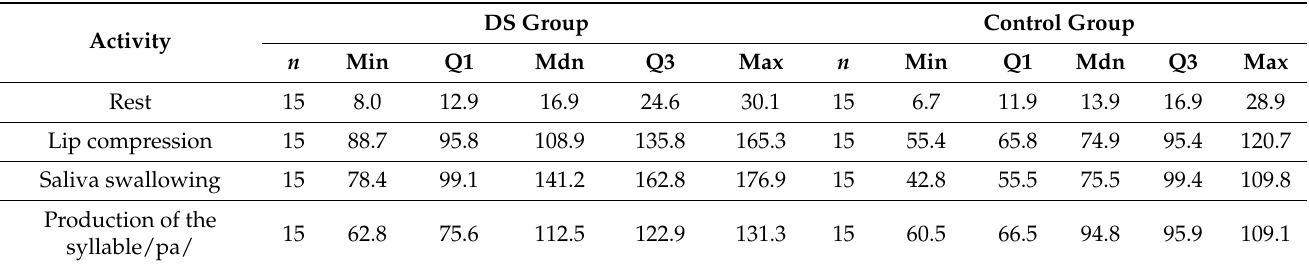
Table 2. Electrical activity of the superior orbicularis oris muscle [ µ V/ µ V%] in the DS and control groups. Activity Rest Lip compression Saliva swallowing Production of the syllable/pa/